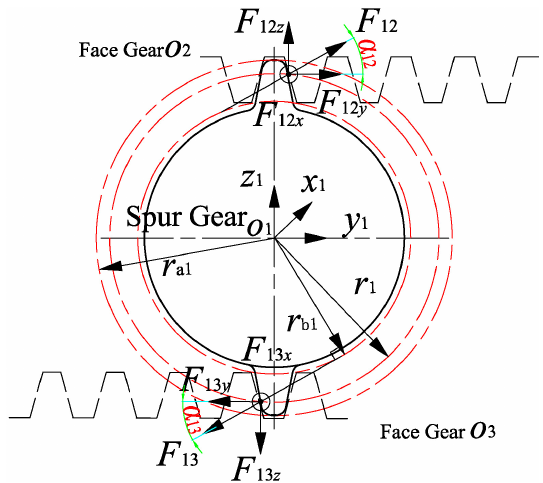
Figure 4. Schematic diagram of the force distribution of the face gear